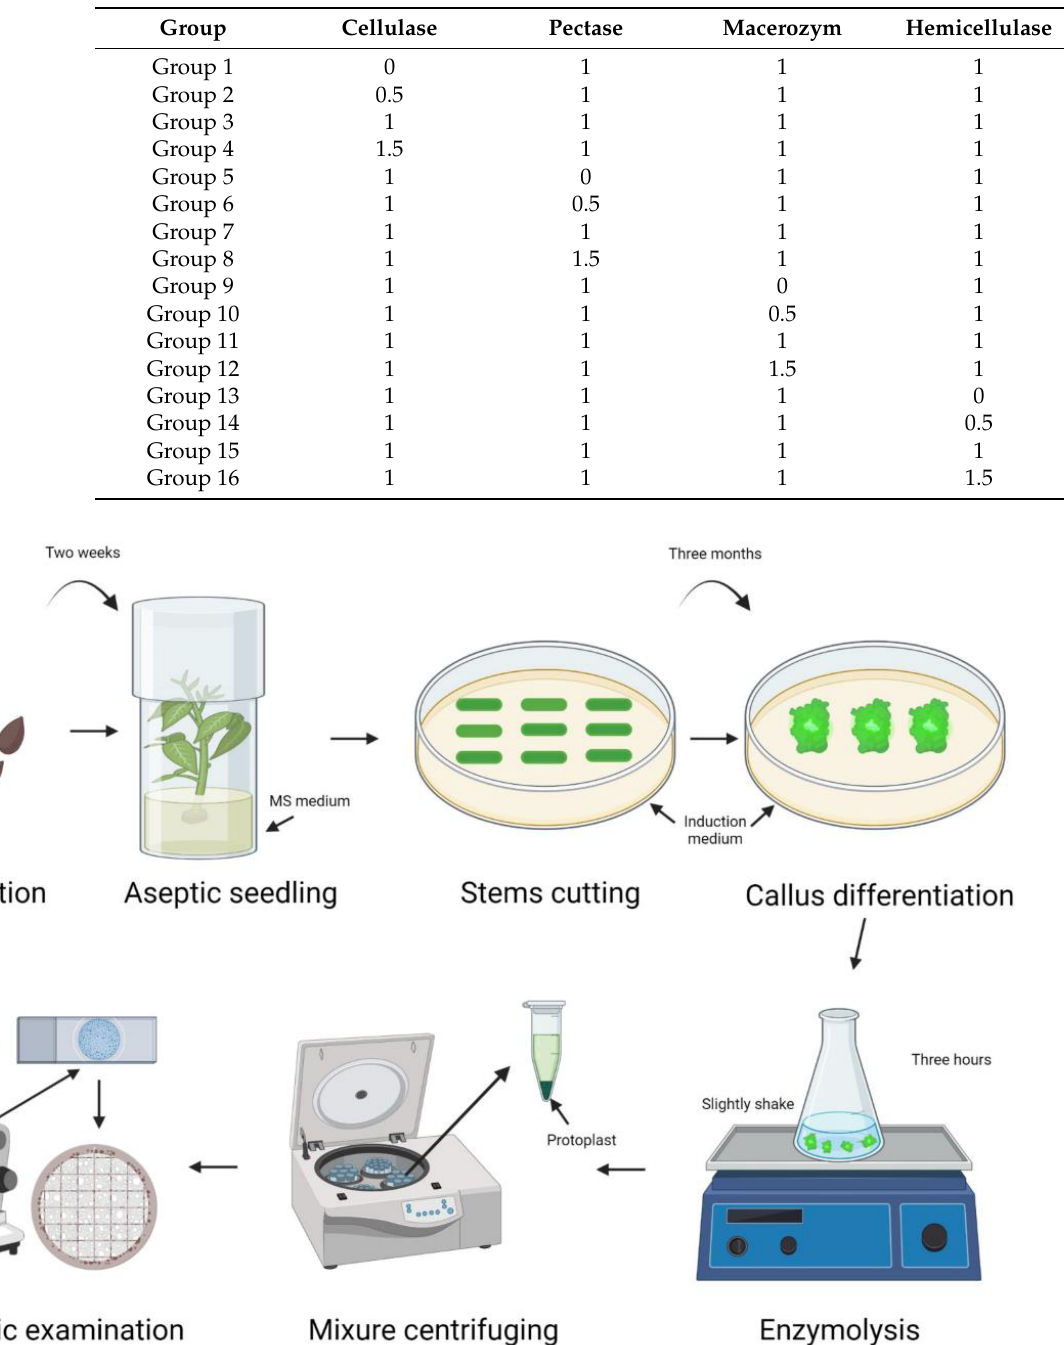
Table 1. The concentration of four enzymes used in different groups.